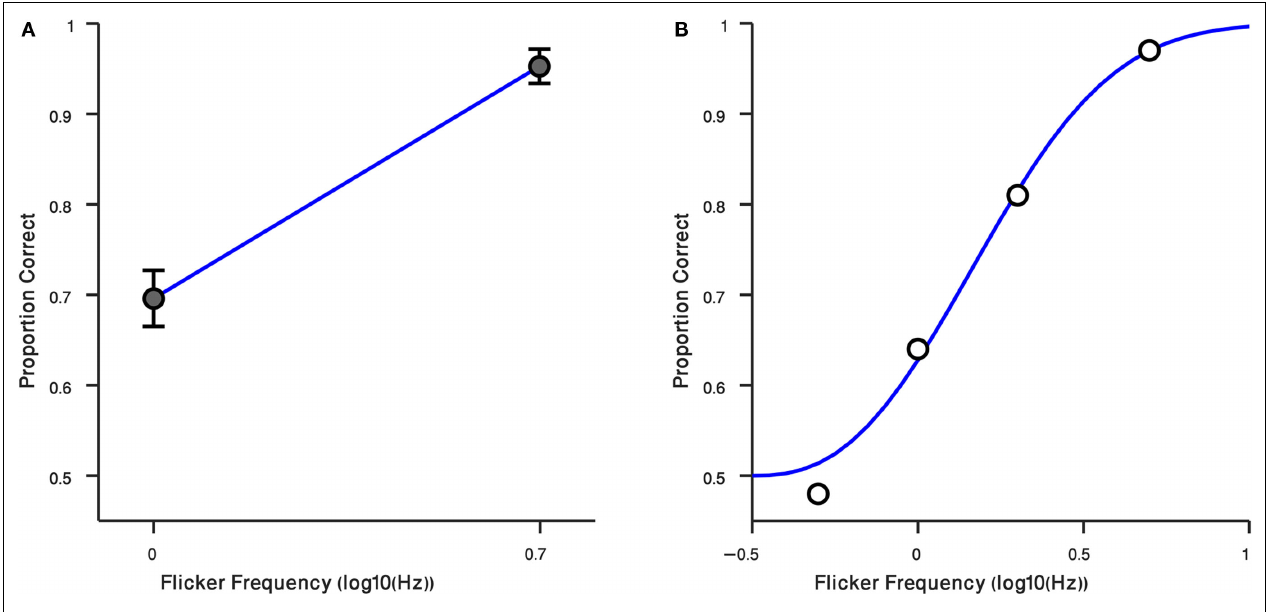
are shown in black circles.The blue curve is aWeibull function fitted to data. Horizontal axis is the log 10 of flicker frequency.Vertical axis plots the proportion of correct